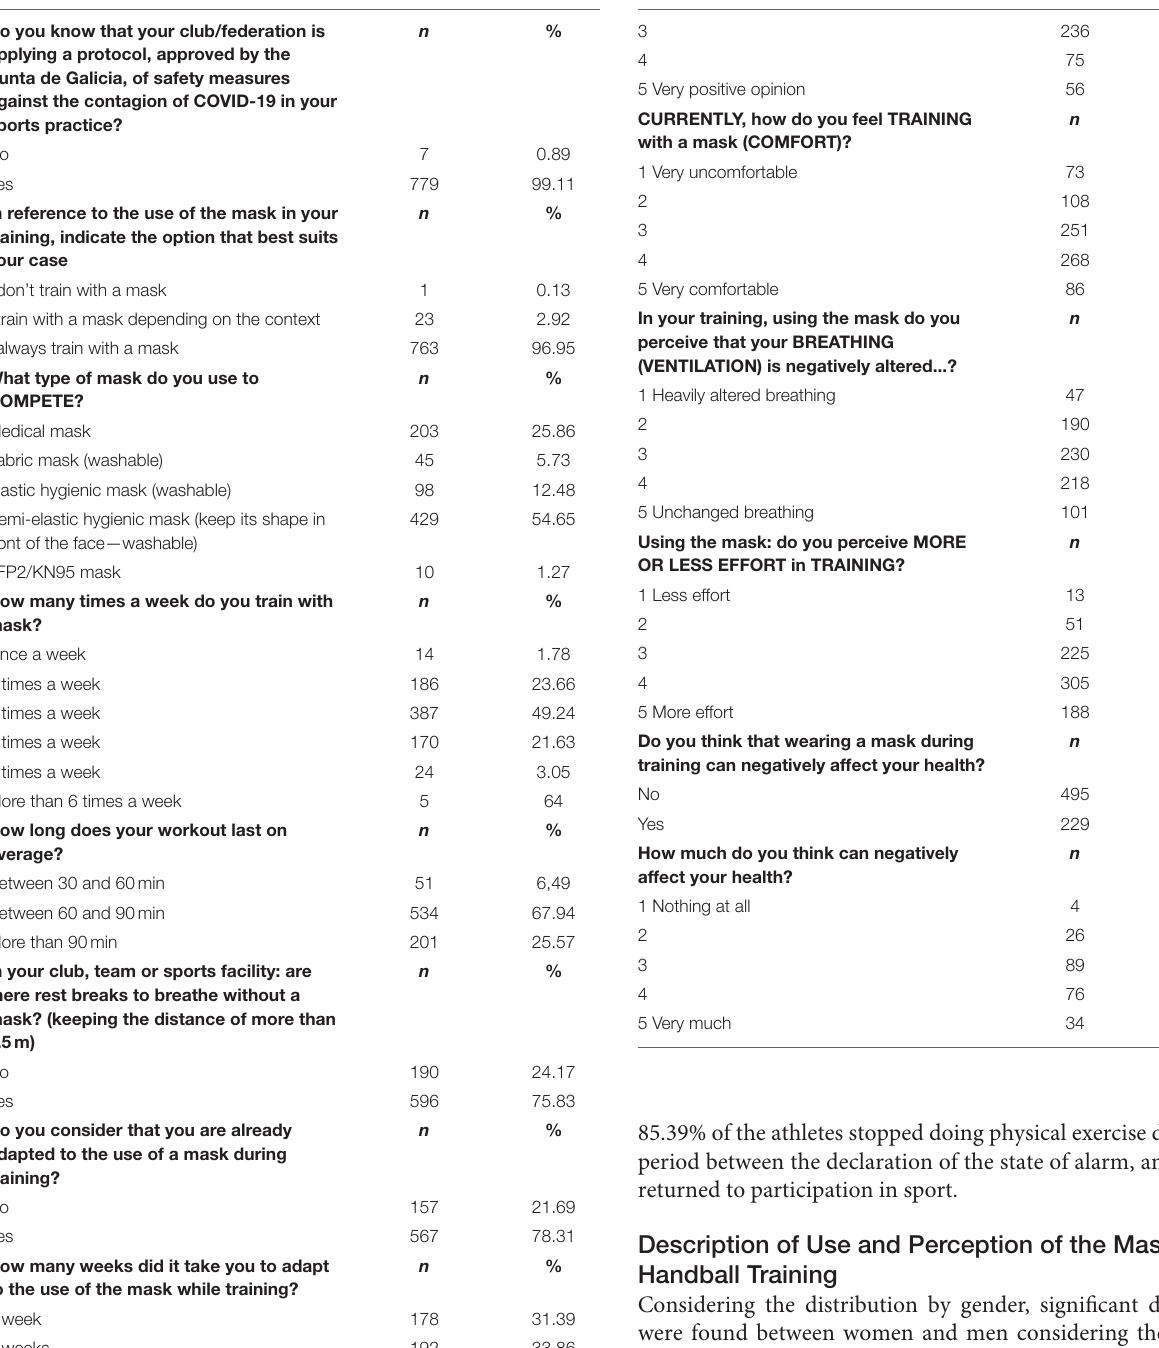
TABLE 2 | Perception of the mask in handball